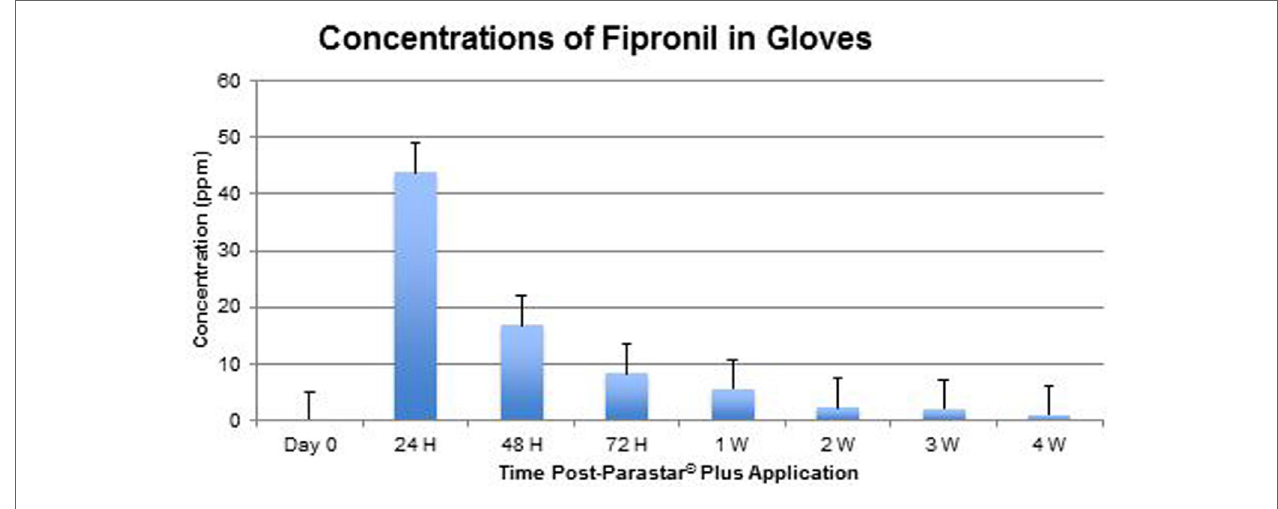
FigUre 4 | concentrations of fipronil in gloves (mean ± seM)